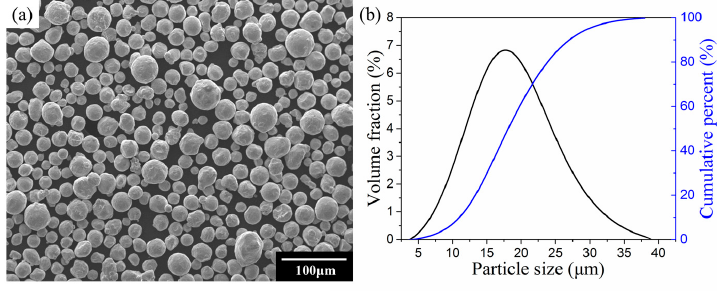
Figure 1. ( a ) Morphology of 316L powder; ( b ) particle size distribution of 316L powder. Table 1. Chemical composition of 316L.